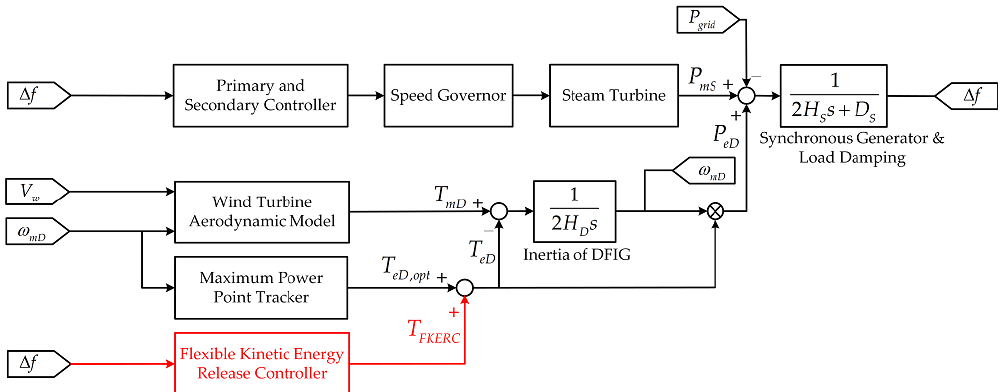
Figure 2. Frequency control functional block diagram for the islanding system.